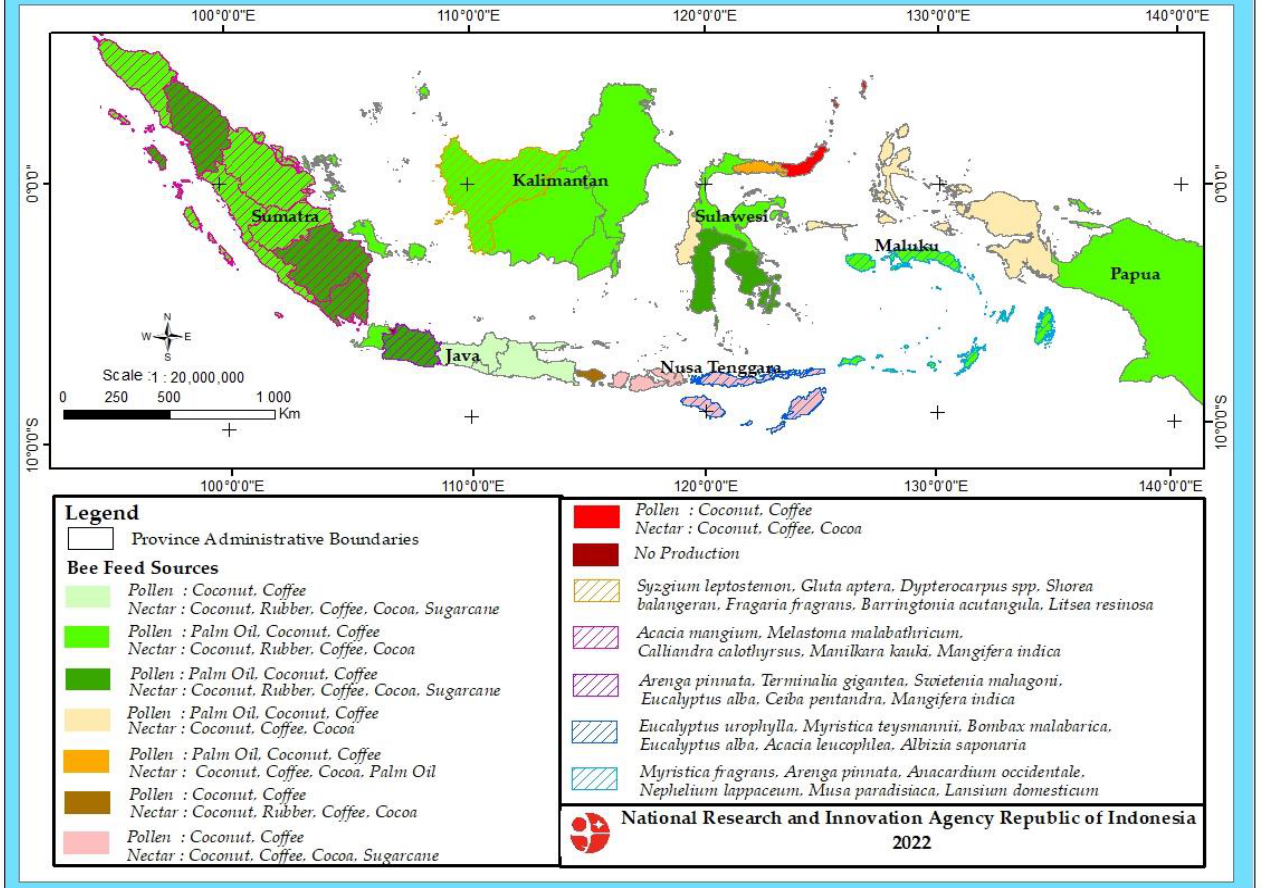
Figure 2. The distribution of bee feed sources in Indonesia